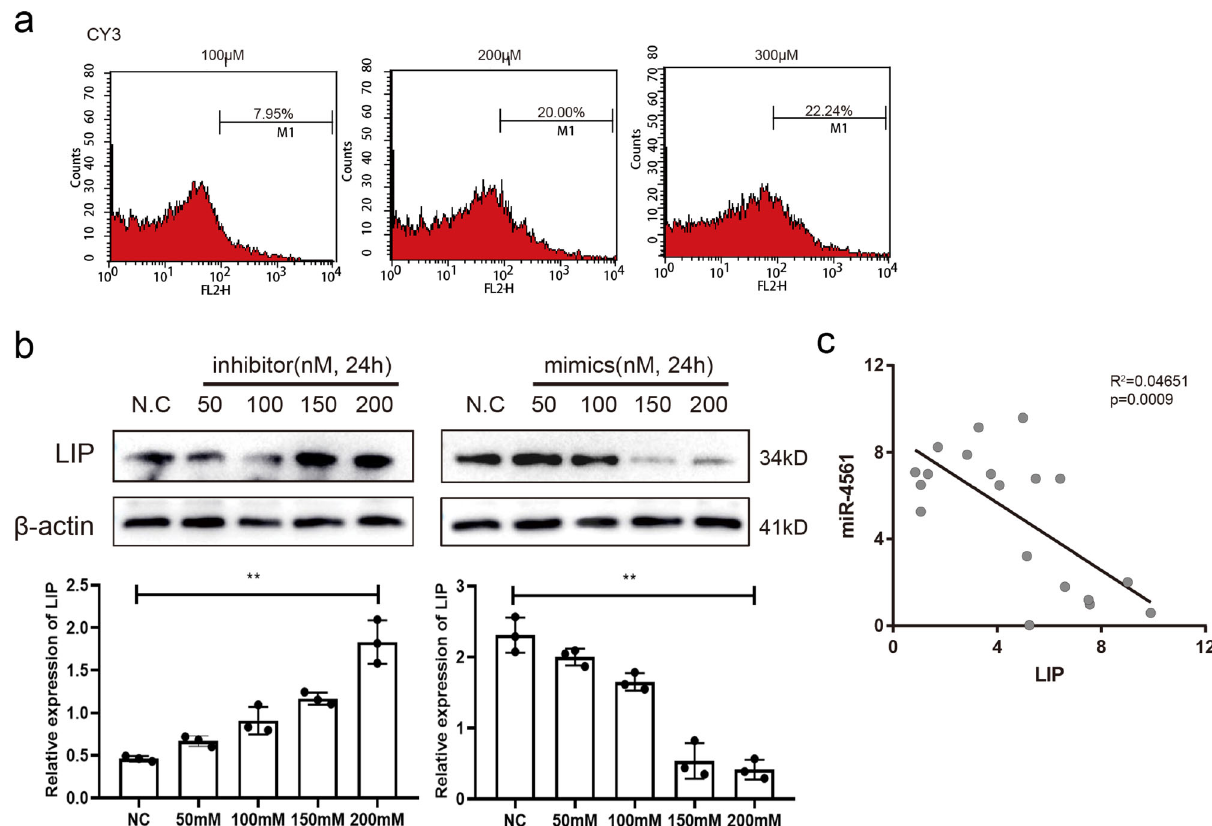
Fig. 5 Overexpression of miR-4561 inhibits LIP expression in lamprey primary supraneural body cells. a Detection of Cy3-labeled miRNA to gauge transfection ef fi ciency. b miR-4561 mimic and inhibitor were transfected into primary supraneural body cells at the indicated concentration. After 24 h of transfection, LIP protein levels were measured by western blotting, using β -actin as loading control. Quanti fi cation of the blots is shown at the bottom ( ** P < 0.01). c Linear regression analysis of the LIP mRNA and miR-4561 expression in 19 lamprey samples, as detected by